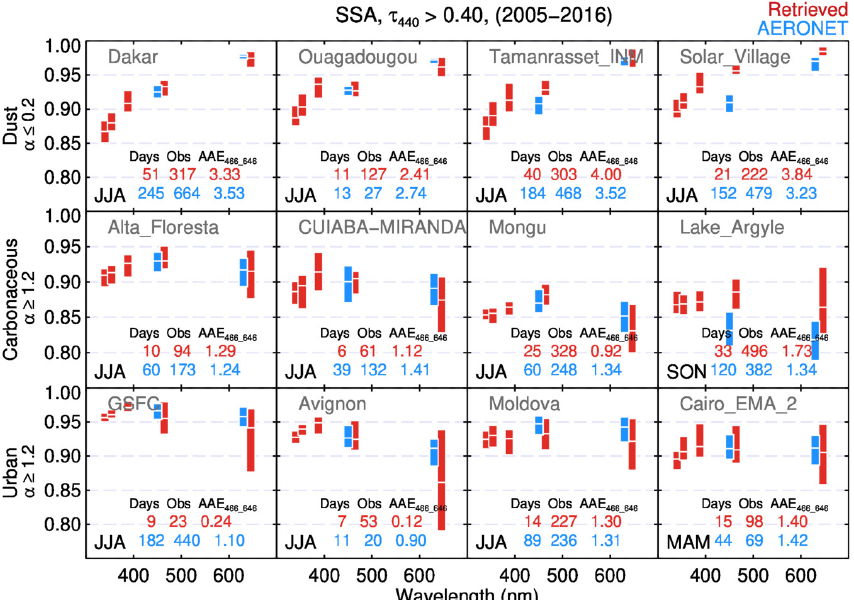
Figure 9. Comparison of retrieved aerosol SSA with that of AERONET for selected sites. Boxplots here represent lower and upper quartile of observations with mean values shown as the white line.